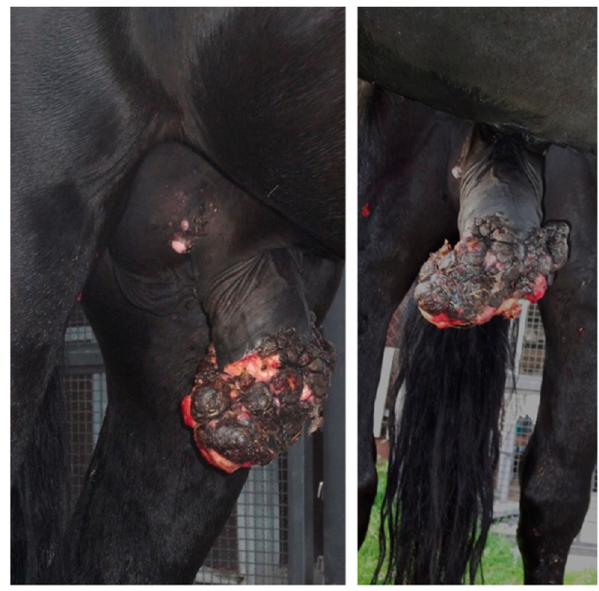
Figure 6. Appearance of the preputial mass on admission (clinical case 3).